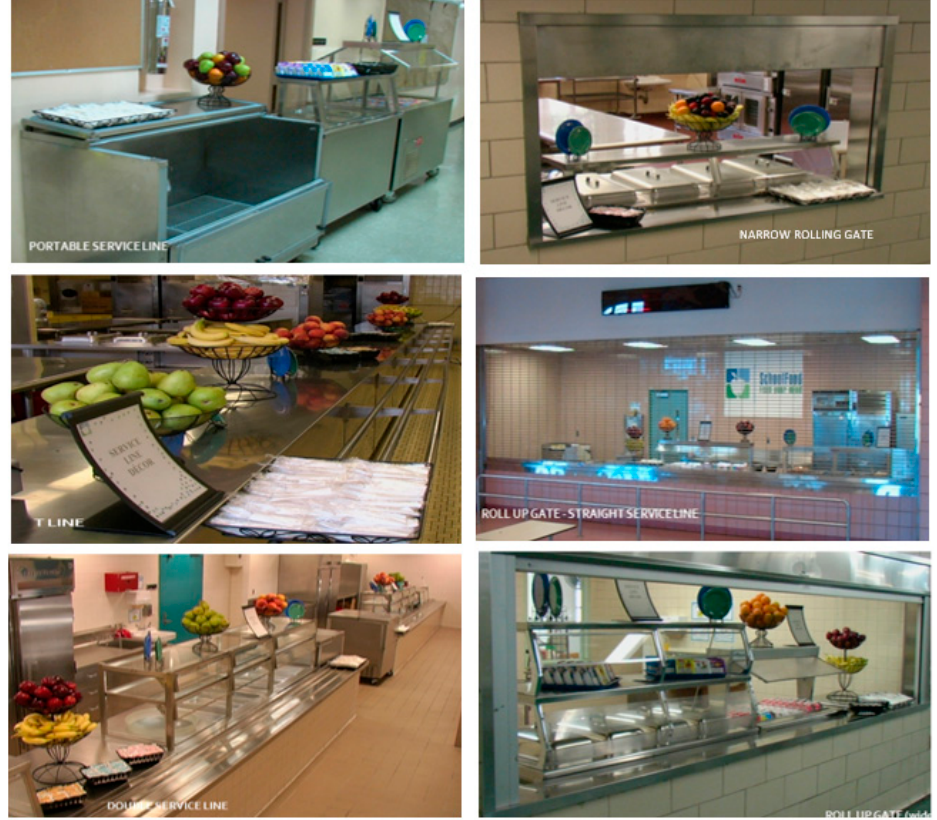
Figure 1. Service Line Types in New York City. From top left to bottom right: Portable Service Line, Narrow Rolling Gate, T-Line, Straight Roll-up Gate, Double Service Line and Wide Roll-up Gate were the six serving line types available to NYC public schools in 2013–2014. Photo source: NYC Office of Food and Nutrition Services.